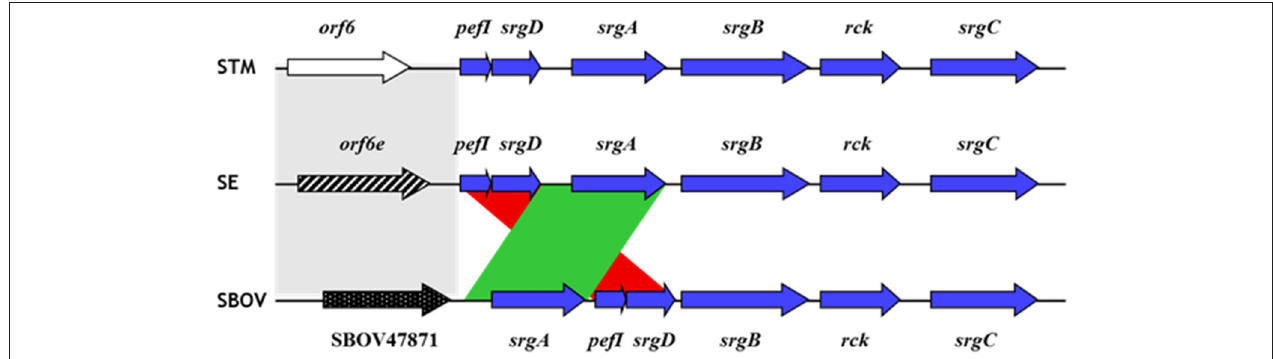
FIGURE 1 | Alignment of the pefI-srgC operons and upstream region of Salmonella . The six ORFs belonging to the pefI-srgC operon are represented by blue arrows. The red and green colored areas indicate the gene rearrangement between SBOV and the two other serotypes. The gray colored area represents heterologous sequences between the three serotypes. STM, S. Typhimurium; SE, S. Enteritidis; SBOV, S. Bovismorbificans.